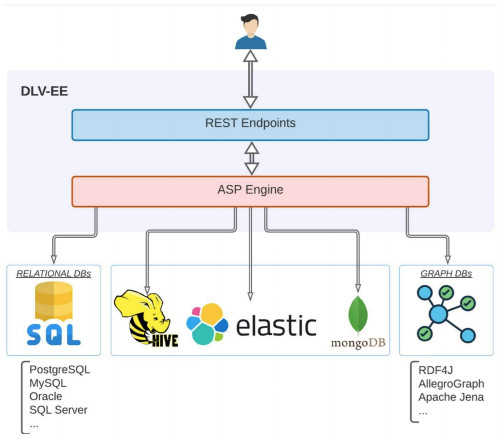
Figure 1. DLV-EE